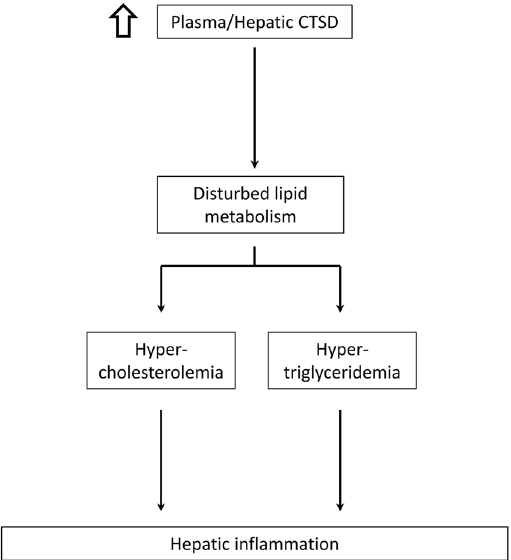
Figure 6. Schematic overview illustrating the proposed by which CTSD participates in the development of hepatic inflammation. Based on findings of the current study, increased levels of CTSD lead to a disturbance in lipid metabolism, which is known to result in increased plasma cholesterol (hypercholesterolemia) and triglyceride (hypertriglyceridemia) levels. Consequently, hypercholesterolemia and hypertriglyceridemia can lead to hepatic